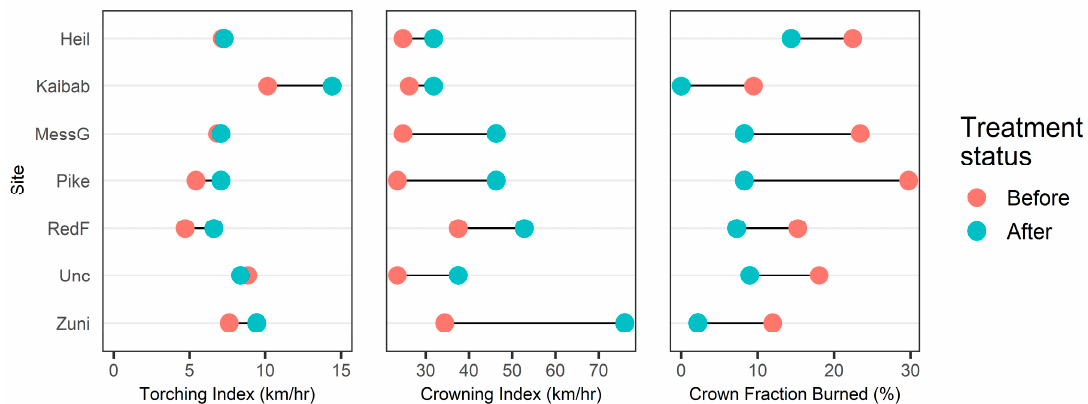
Figure 1. Torching index, crowning index and crown fraction burned predicted using the Rothermel modeling system in the firebehavioR package.